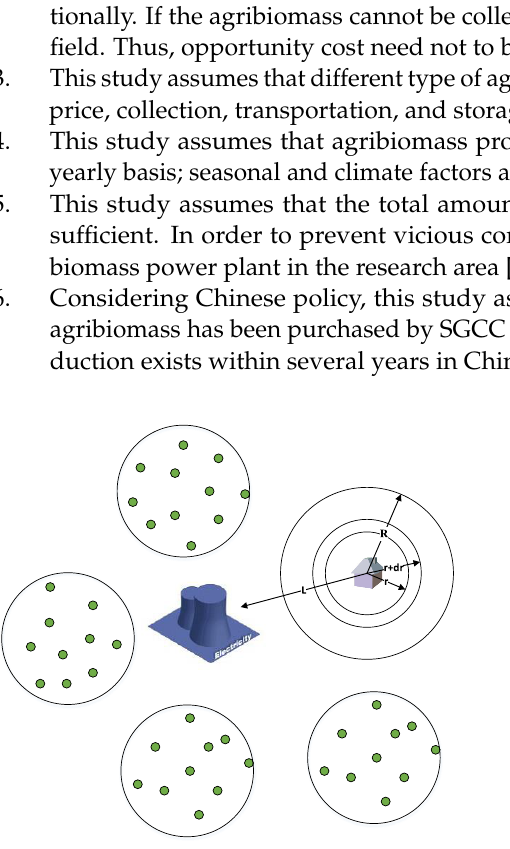
Figure 2. Collection area, facility location, and transportation distance.